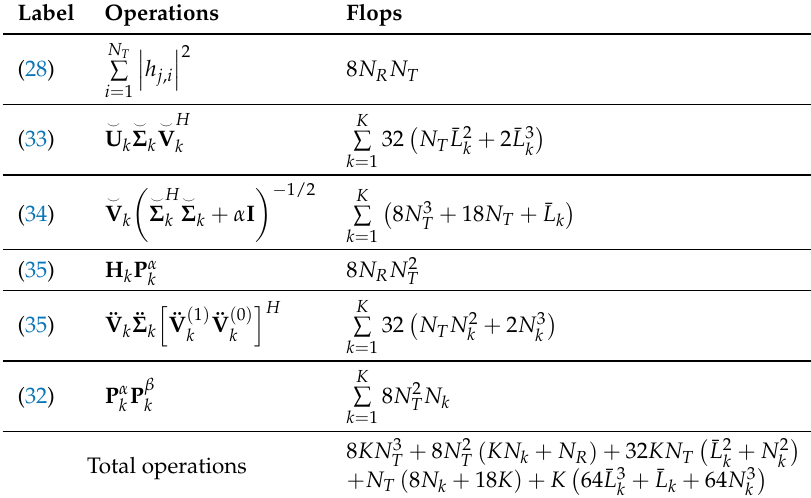
Table 4. Computational complexity of each operation for proposed scheme at